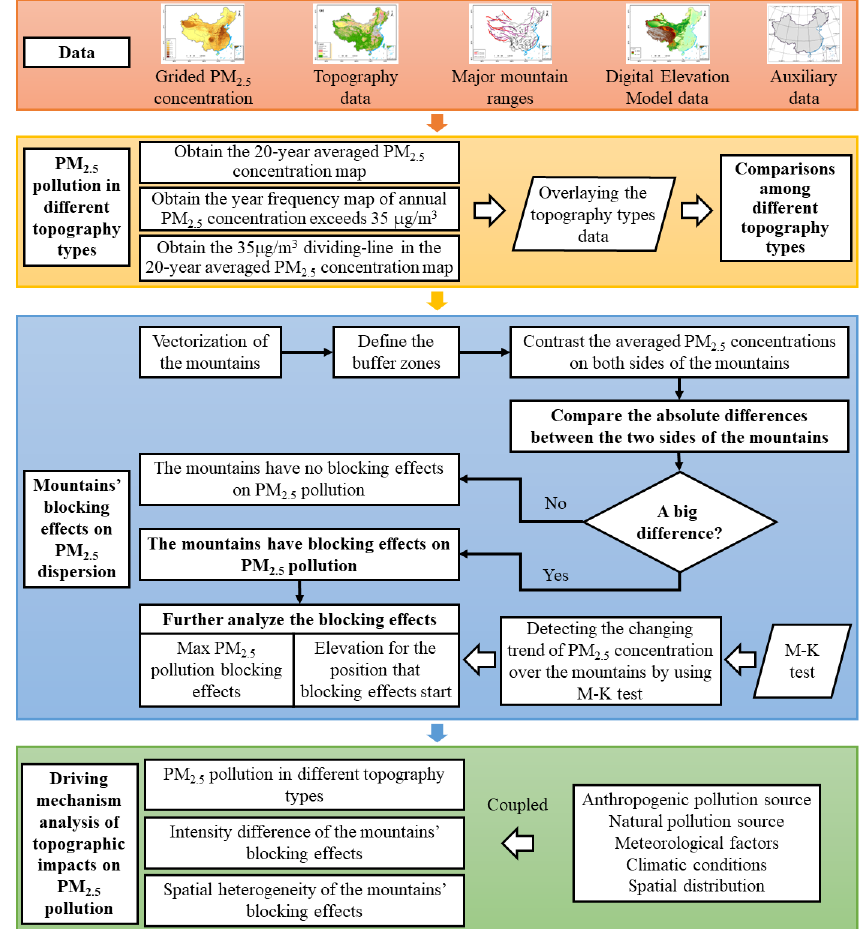
Figure 2. Technology